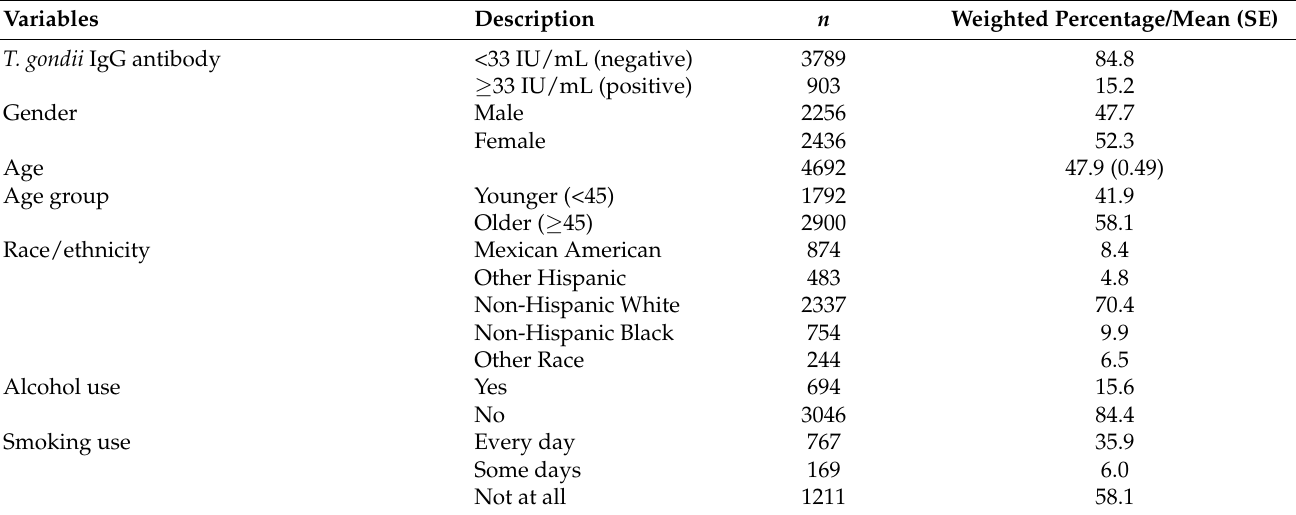
Table 1. Summary statistics for the variables included in the analysis ( n =